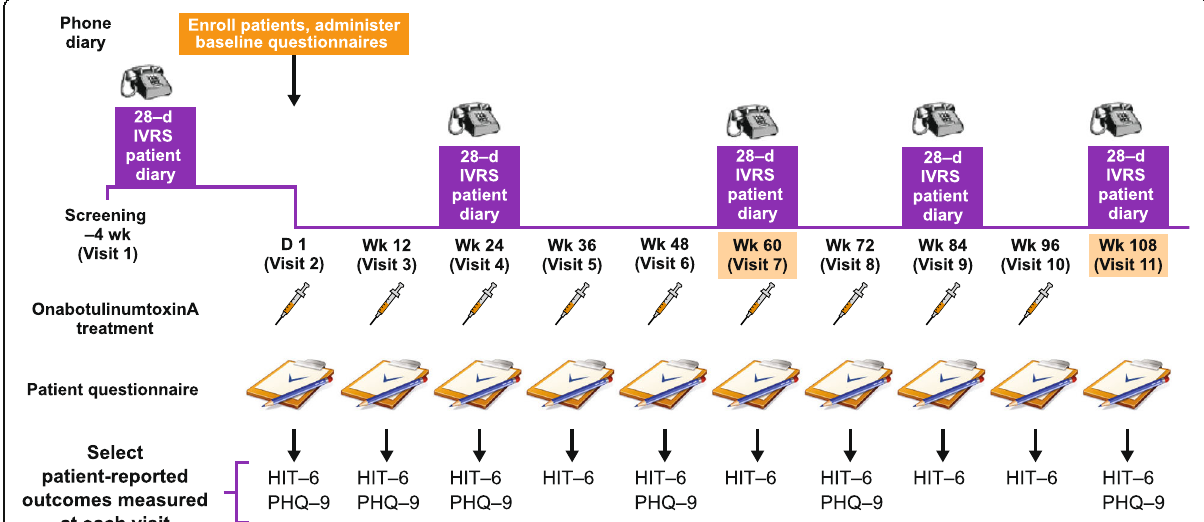
Fig. 1 Overview of COMPEL Study design. HIT-6 = 6-item Headache Impact Test; IVRS = interaction voice response system; PHQ-9 = 9-item Patient Health Questionnaire. Adapted from Blumenfeld AM, Aurora SK, Laranjo K, Papapetropoulos S. Unmet Clinical Needs in Chronic Migraine: Rationale for Study and Design of COMPEL, an Open-Label, Multicenter Study of the Long-Term Efficacy, Safety, and Tolerability of OnabotulinumtoxinA for Headache Prophylaxis in Adults With Chronic Migraine. BMC Neurol. 2015; 15: 1 –